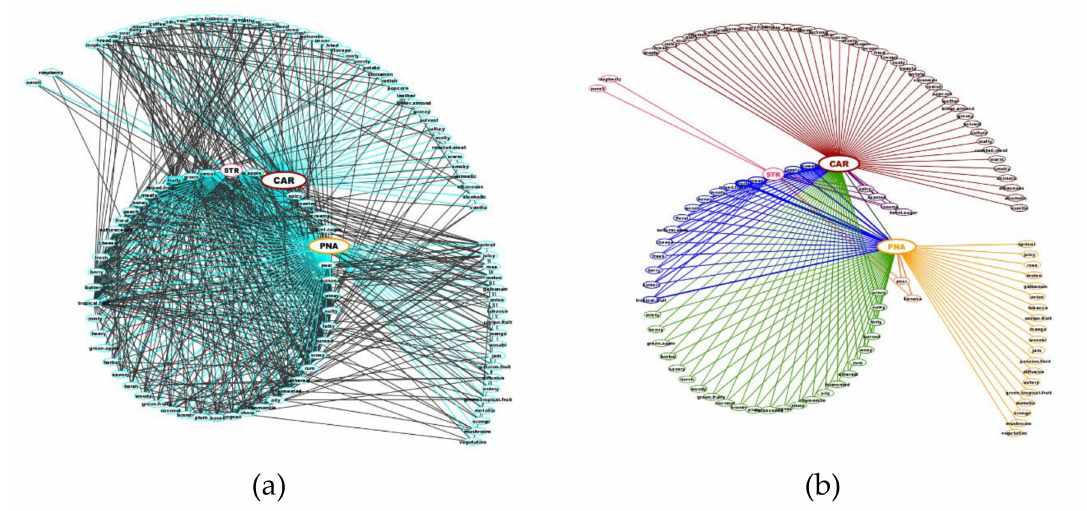
Figure 1. Network of odor notes in the StCaPi-set: ( a ) the whole network of odors (750 pairs): in blue, 174 links linked to STR, CAR or PNA, and in gray, 576 links between the other odor notes. ( b ) The network of pairs involving STR, CAR or PNA (172 pairs); Level L1 links to STR (2 odors) are shown in pink, L1 links to CAR (43 odors) are shown in brown, and L1 links to PNA (19) are shown in pale orange. Level L2 links: 15 odorants link STR-CAR-PNA (in blue), 4 odorants link STR-CAR (in purple), 2 odorants link STR-PNA (in orange-pink), and 24 odorants link CAR-PNA (in